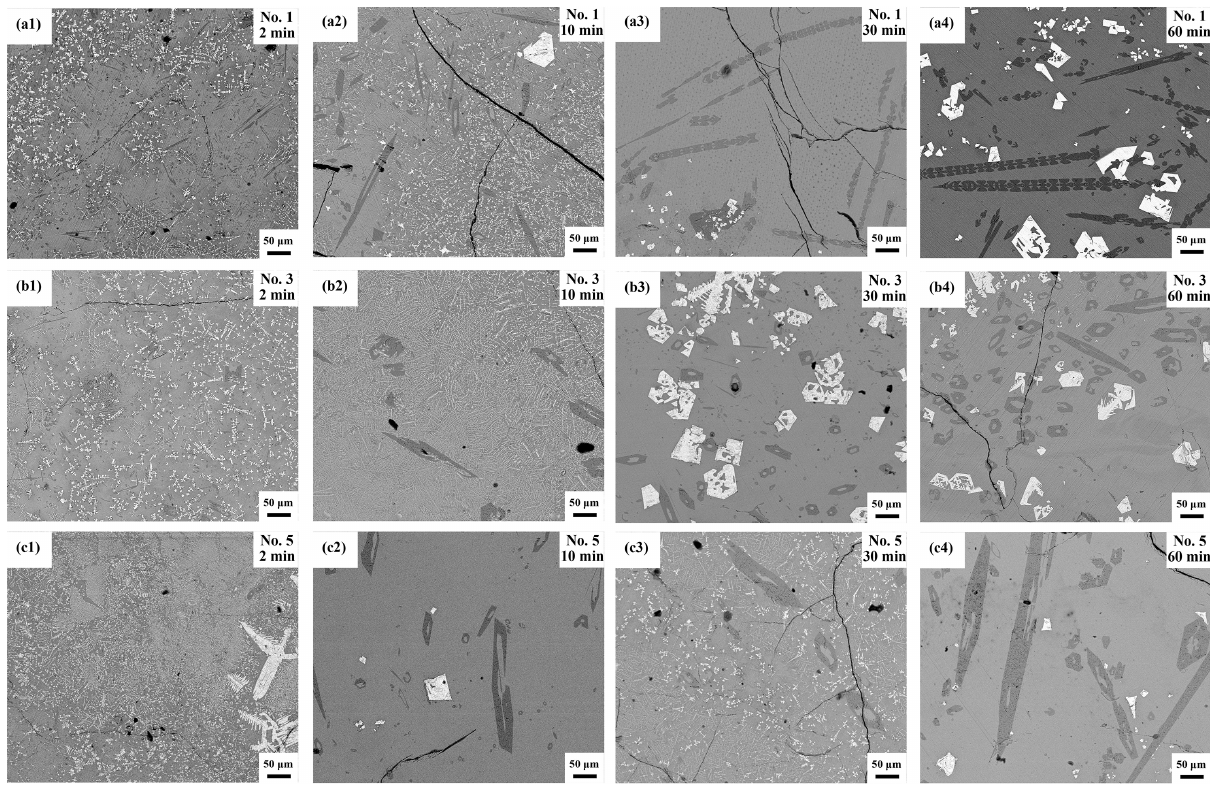
Figure 3: SEM images of No. 1, No. 3 and No. 5 test-run slag samples at three endpoint temperatures of 1453 K (a), 1493 K (b), and 1533 K (c) with four holding times in 2, 10, 30, 60 min,